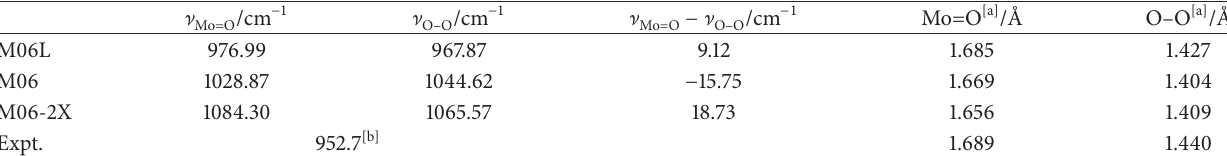
Table 5: Mo=O and O–O stretching, and Cp’s C–H OOP bending frequencies for 1 - CF 3 .